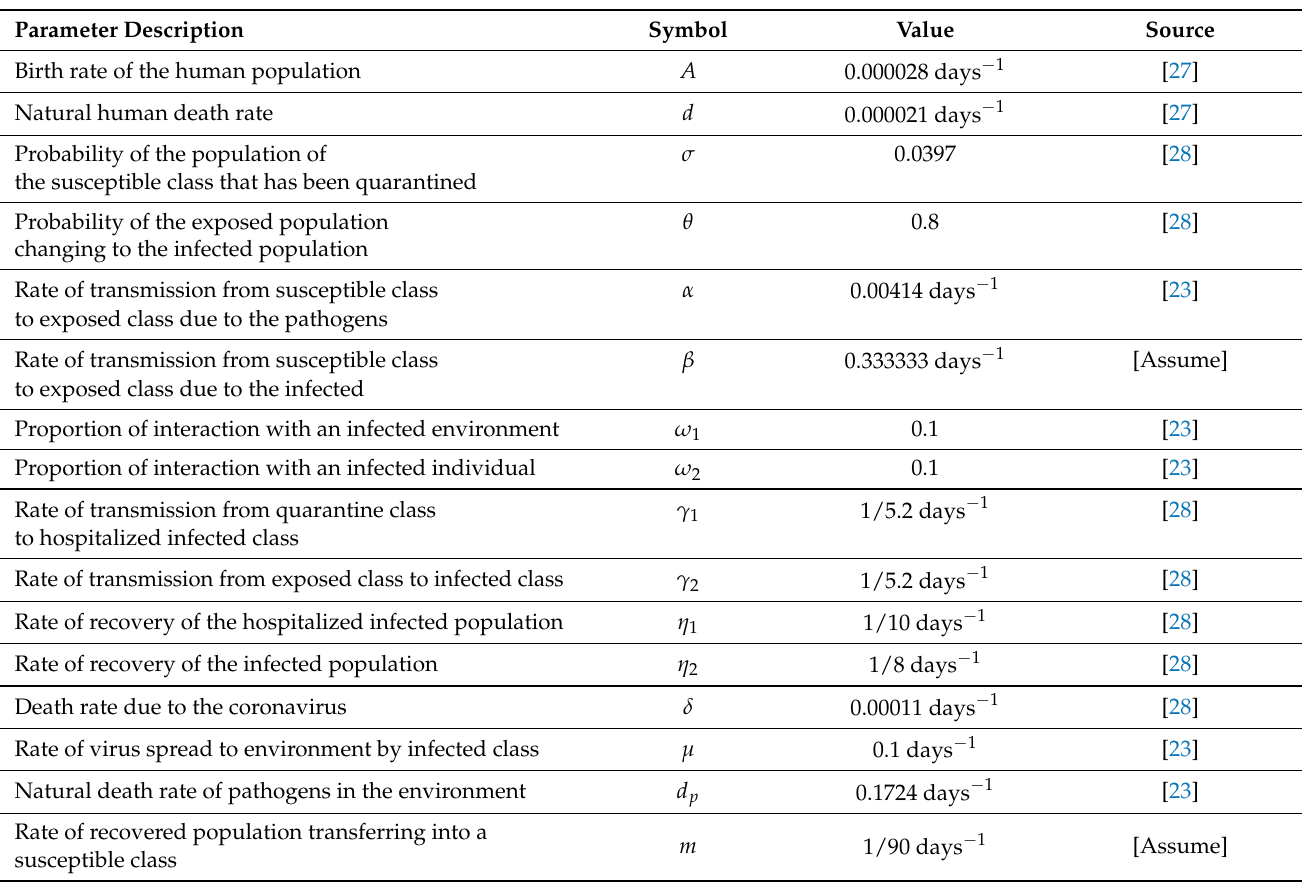
Table 1. The value of the parameter of the SQEIRP